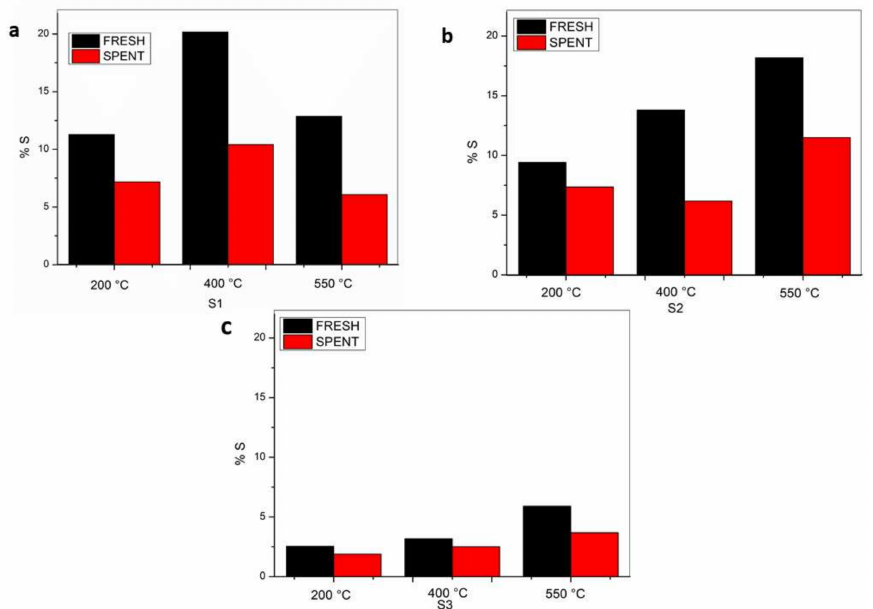
Figure 20. EDS data of ( a ) S1 catalysts, ( b ) S2 catalysts, and ( c ) S3 catalysts at sulfidation temperatures of 200 ◦ C, 400 ◦ C, and 550 ◦